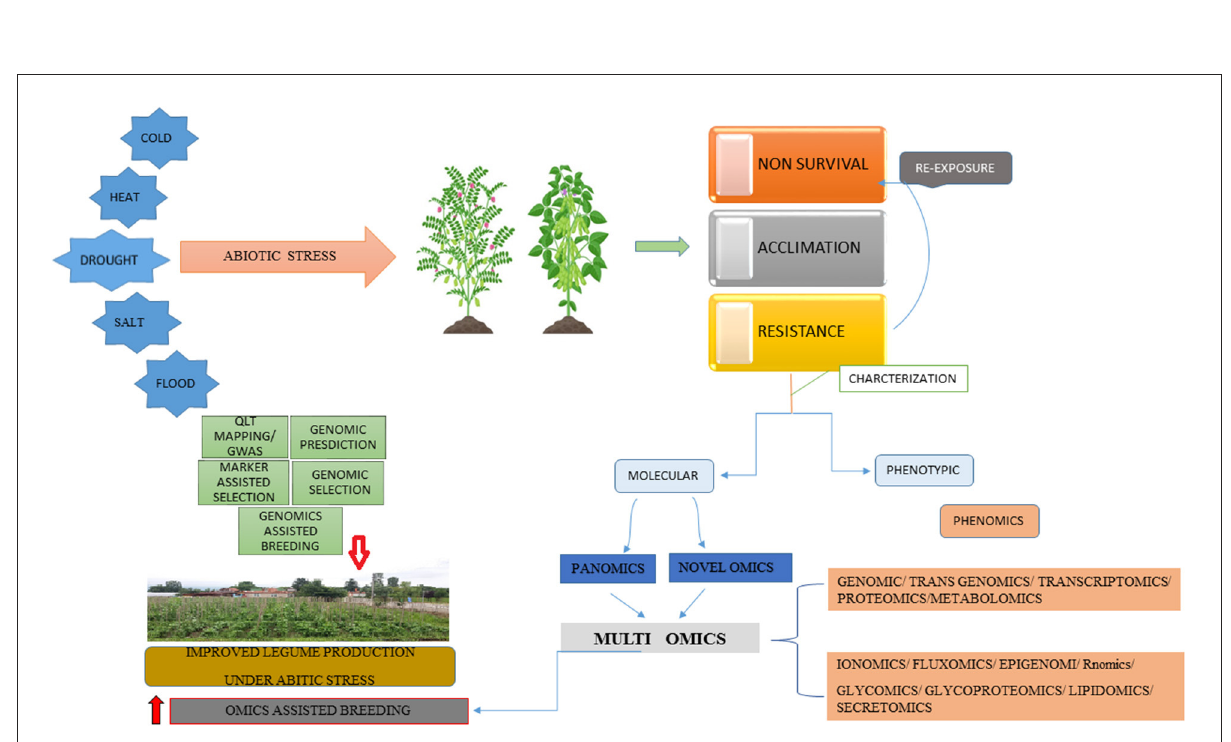
FIGURE4 Improved abiotic stress tolerance in legumes using integrated multi-omics